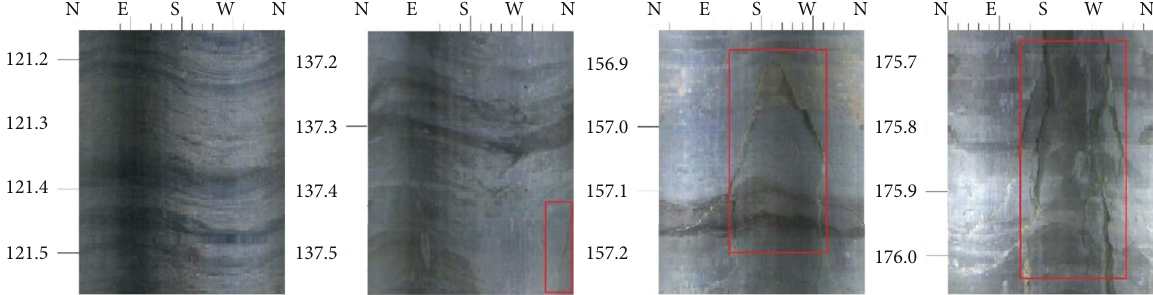
Figure 7: Video camera images of JE3 borehole: (a) no fracture; (b) initial high angle no-though fracture; (c) fi rst fresh penetrative vertical fracture; and (d) TFZ. Table 4: Top boundary depths and heights of the TFZ in boreholes.